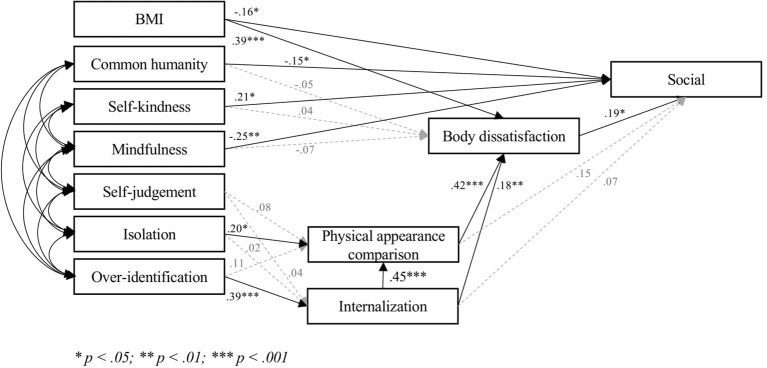
Final model social.